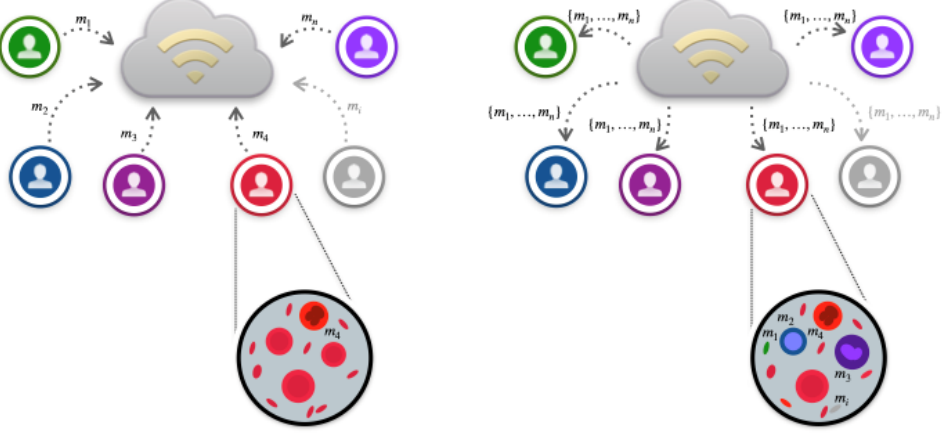
Figure 1. FLEA migration. The left side of the figure sketches the migration from the slaves to the master, while the right one traces the migration from the master to the slaves. The largest circles show single slaves with the corresponding local individuals, i.e., prediction models ( m 1 , . . . , m n ). In particular, the individuals internal to the left-side circle have the same color because the models are all related only to local data. Differently, the individuals inside the right-side circle indicate that each slave, after communication with the master, can integrate the information from the immigrants by exploiting the mechanism of selection, replacement, and genetic operators, as evidenced by the color overlapping of the single